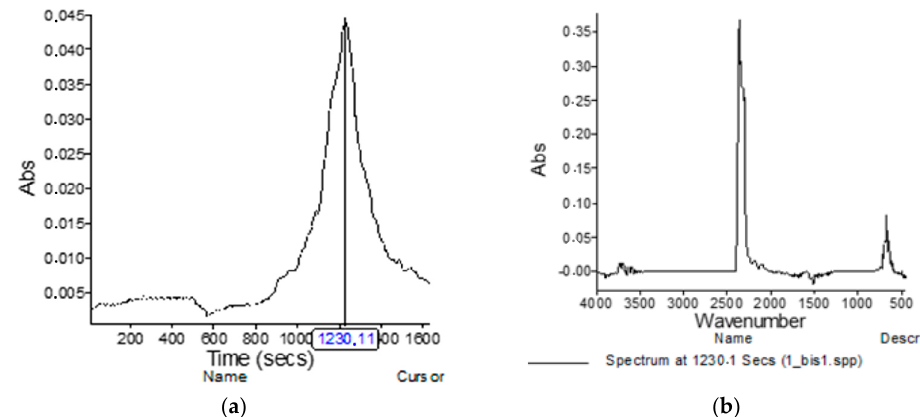
Figure 12. TG-IR analysis of a sample of the basic material from which the overalls were made: ( a ) absorption spectrum of the highest concentration of gaseous decomposition products; ( b ) meas- ured gases on IR at temperature 615 °C.